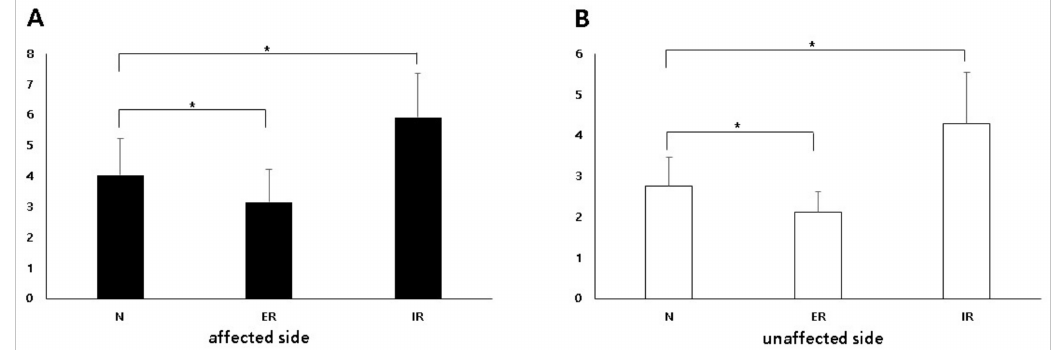
Figure 5. Comparison of the inferior joint capsule thickness between three different positions on both the affected ( A ) and unaffected ( B ) sides. * Statistically significant.